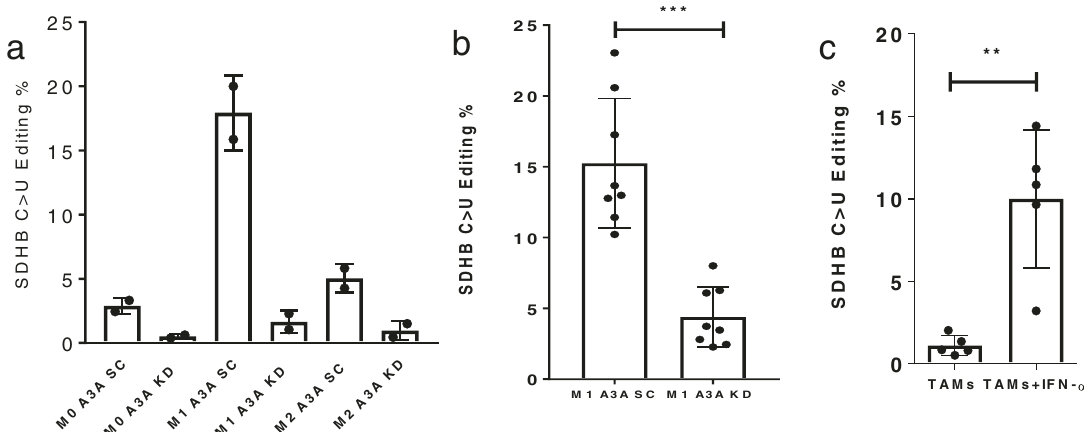
Fig. 1 SDHB c.C136U RNA editing is induced in M1 macrophages and mediated by A3A. a RNA editing was induced in M1 macrophages but not in M0 or M2 macrophages ( n = 2 replicates from 1 representative donor). b A3A was required for SDHB RNA editing. P = 0.0001, Paired t test, two-tailed, n = 8 donors. c IFN-1 (IFN- α , 1000U/ml) induces RNA editing in ovarian tumor associated macrophages (TAMs) from ascites of ovarian cancer patients. P = 0.0084, Paired t test, two-tailed, n = 5 donors. Data in scatter dot plots with mean±SD. (see “ Methods ” section for macrophage polarization and